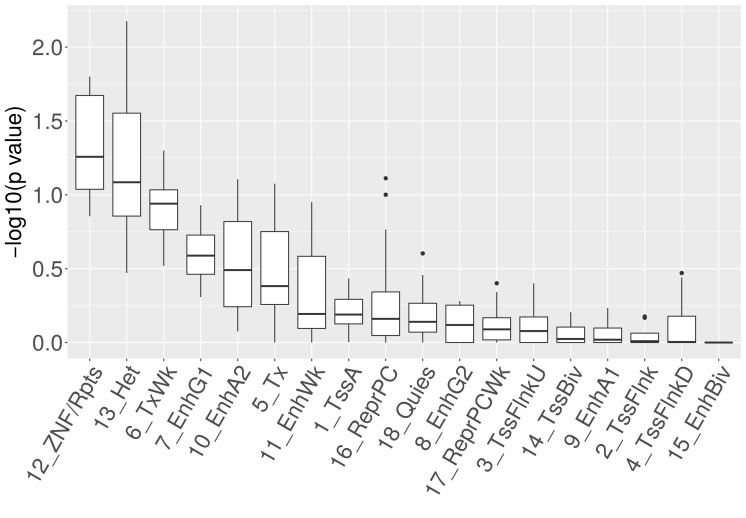
Enrichment of chromatin states at breakpoints for different cell-of-origin associations.For the original and alternative selections of reference epigenomes, the states 'ZNF genes and repeats' (12_ZNF/Rpts) and ‘Heterochromatin’ (13_Het) show the most significant enrichments [chi-square test; chromatin state labels according to 18-state model (Kundaje et al., 2015).